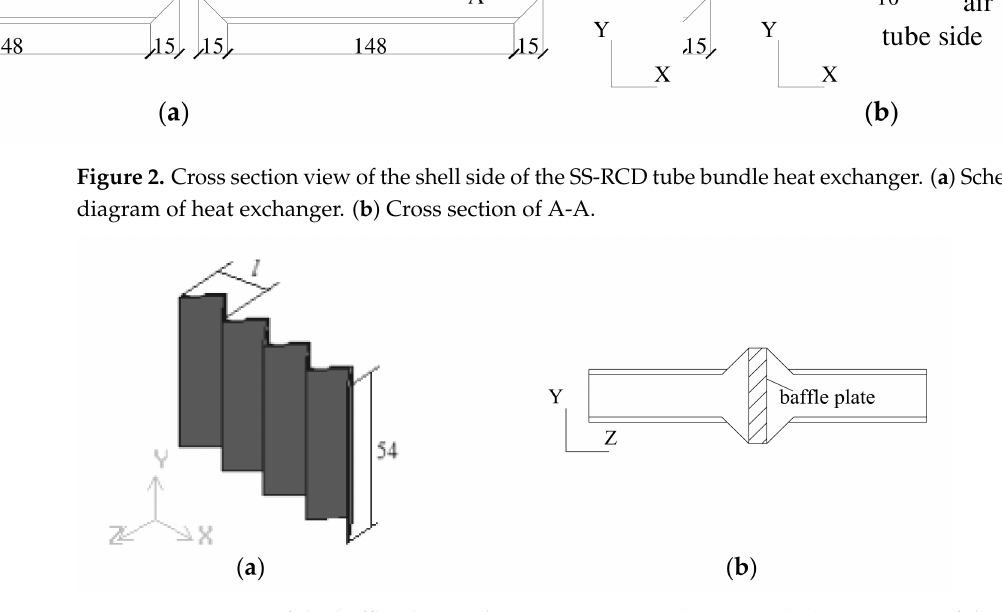
Figure 3. Structure of the baffle plate and its insert position (units: mm). ( a ) Structure of the baffle plate. ( b ) Position of the baffle